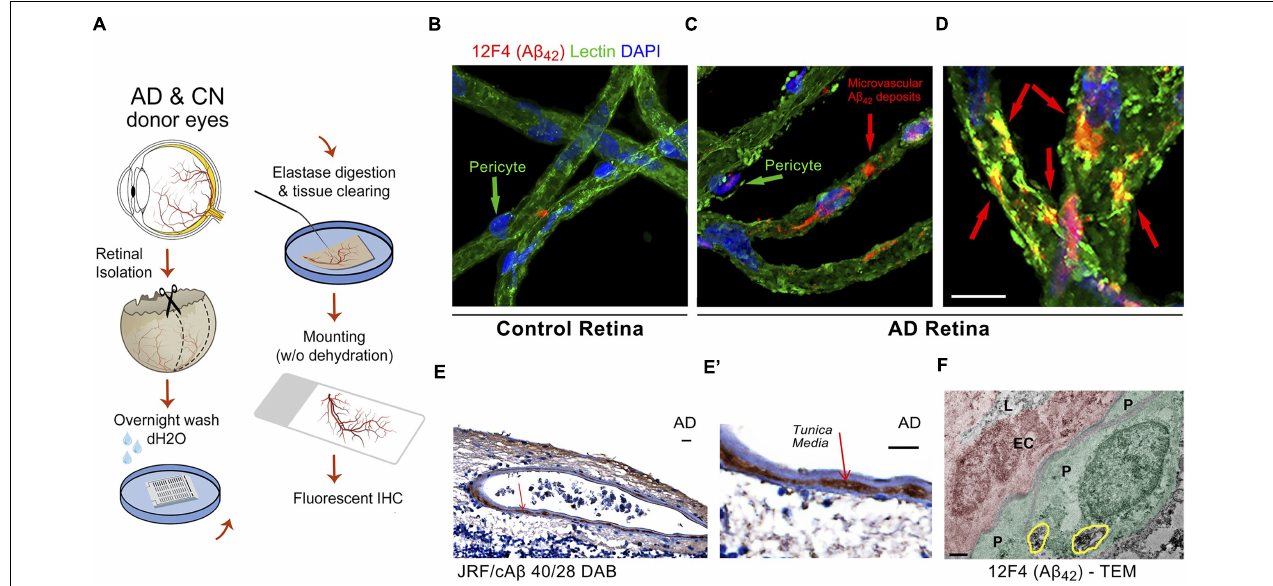
FIGURE 6 | Identification of early and progressive PDGFR β /pericyte loss, associated with vascular amyloidosis in AD retina. (A) Schematic diagram of retinal vascular network isolation and immunofluorescence staining. (B,C) Representative fluorescent images showing A β 42 (12F4 immunoreactivity in red), blood vessels (lectin in green) and nuclei (DAPI in blue) in isolated retinal microvasculature networks from a cognitively normal (CN) control subject (B) and AD patient (C) , with higher A β 42 deposits in AD retinal microvasculature and pericytes. (D) Higher magnification image of AD retina shows co-localization of A β 42 and lectin-positive vascular walls in yellow. (E,E’) Retinal cross-section from an AD patient immunostained with anti-A β 40 (JRF/cA β 40 / 28 ) mAb and DAB labeling and hematoxylin counterstain. Red arrow, also shown in higher magnification image (E’) , points to vascular A β 40 in tunica media, adventitia or intima. Scale bar: 20 µ m. (F) TEM image of retinal cross-section from an AD patient immunostained with anti-A β 42 mAb (12F4) and peroxidase-based DAB, revealing the localization and ultrastructure of vascular-associated deposits. Cytoplasmic A β 42 deposits in pericytes are demarcated by yellow lines. Scale bar: 0.5 µ m. Reproduced from Shi et al. (2020) under terms of the Creative Commons Attribution 4.0 International License